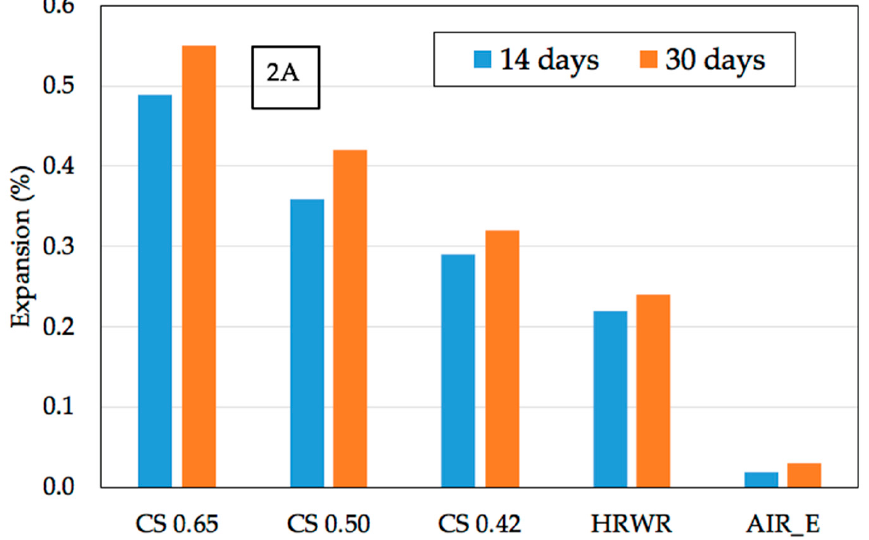
Figure 5. Mortars’ expansion according to Procedure 2A.